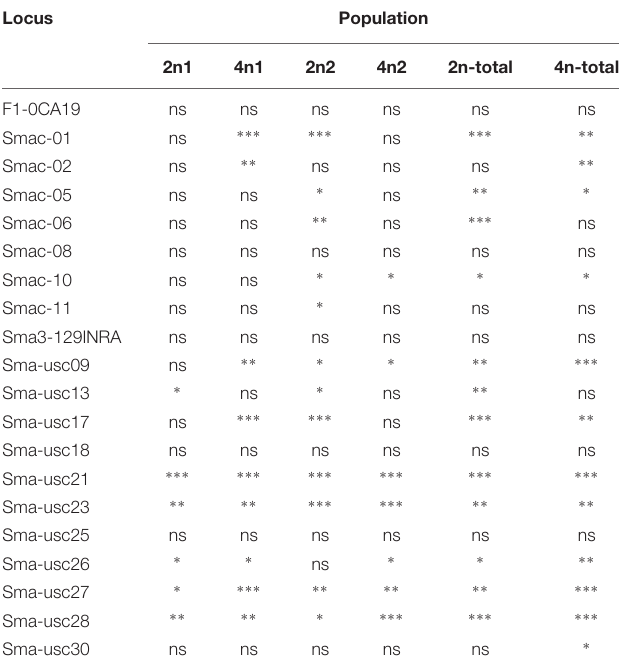
TABLE 5 | Hardy–Weinberg equilibrium in 2n and 4n populations.